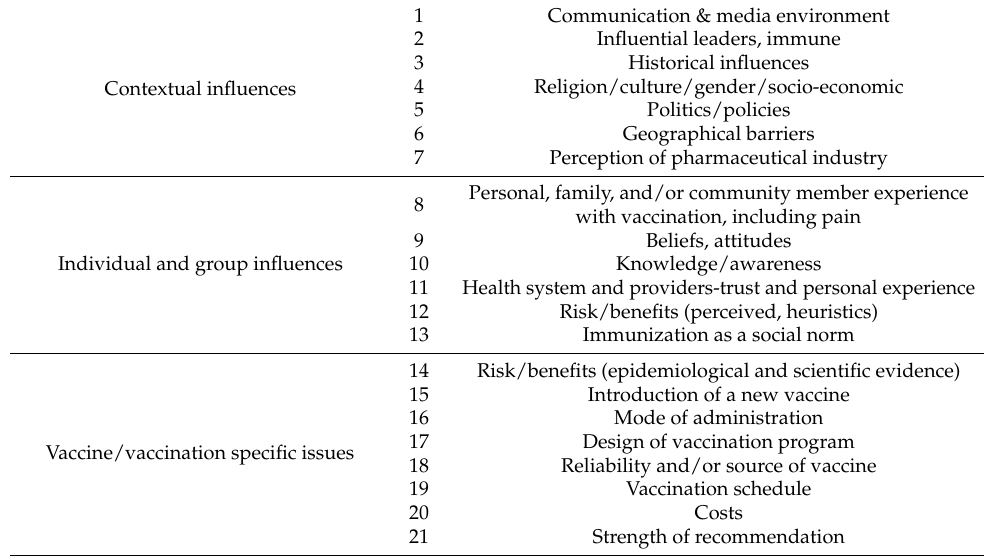
Table 1. Matrix of Determinants (MxDt) of vaccine hesitancy